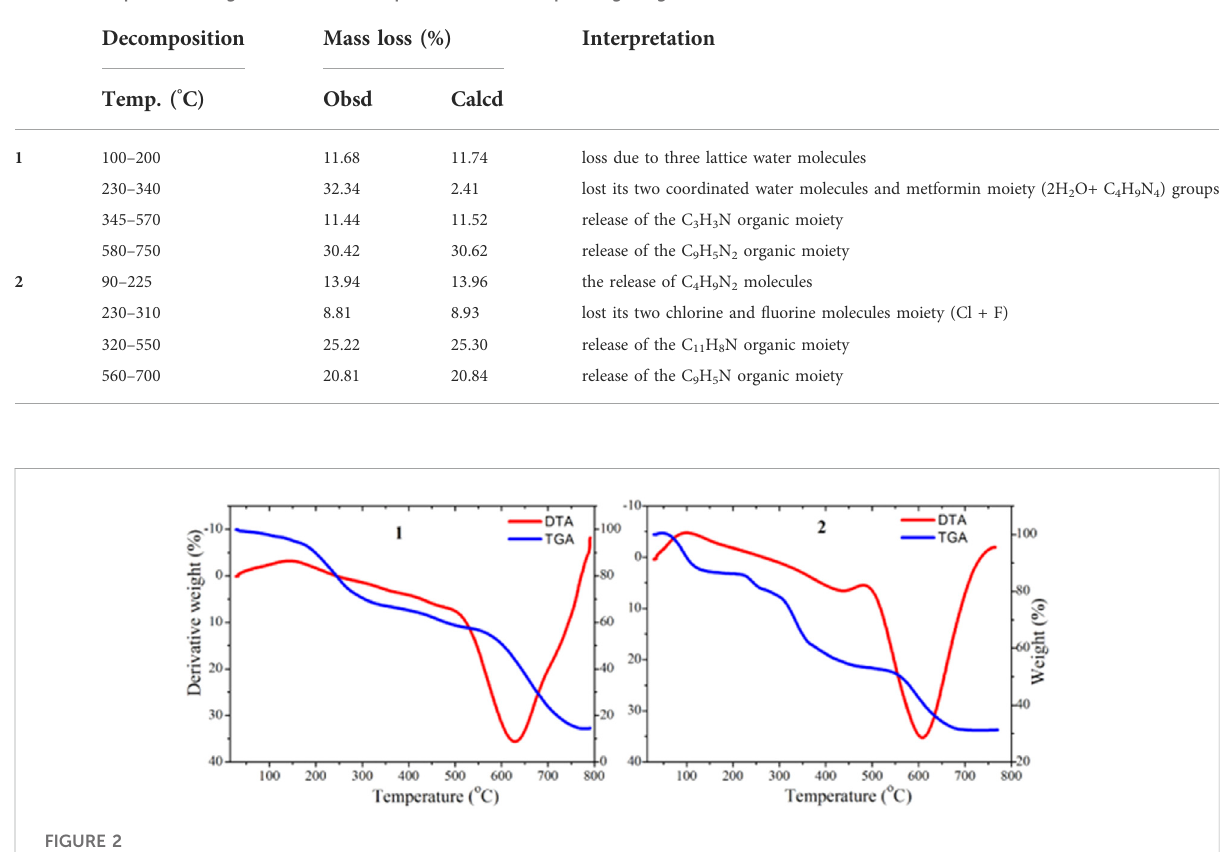
TABLE 2 Temperature range values for decomposition and corresponding weight loss values.